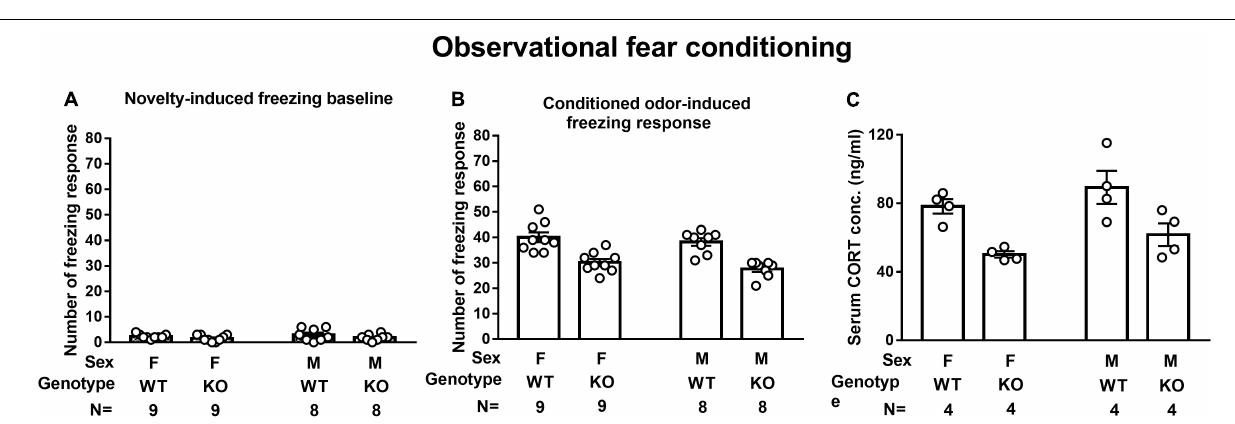
FIGURE 3 | Hippocampal mGluR5 level in two sexes of WT and SEPT14 KO mice. (A) Male SEPT14 KO mice demonstrated elevated mGluR5 levels in dorsal hippocampal samples. *Significantly greater than the remaining three groups ( p < 0.05). (B) Male SEPT14 KO mice demonstrated elevated mGluR5 levels in ventral hippocampal samples. ∧ Significantly lower than the remaining three groups ( p < 0.05). The bar and error bar represent group mean and SEM, respectively.